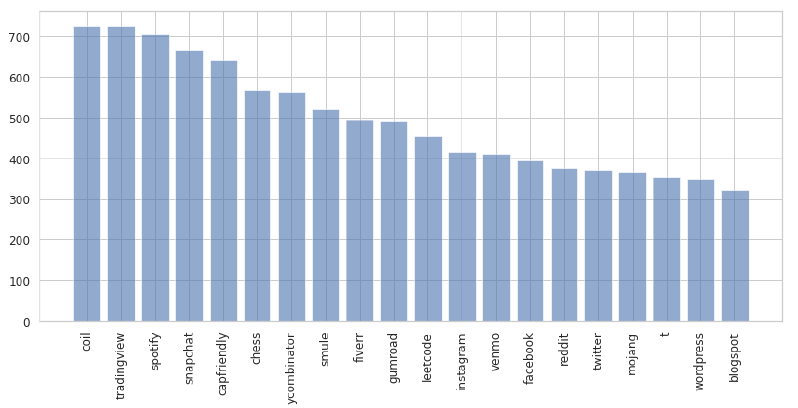
Figure 15. Top 20 social networks with Odysee accounts hunted down by username. The x-axis shows the social networks and y-axis the number of account found in the